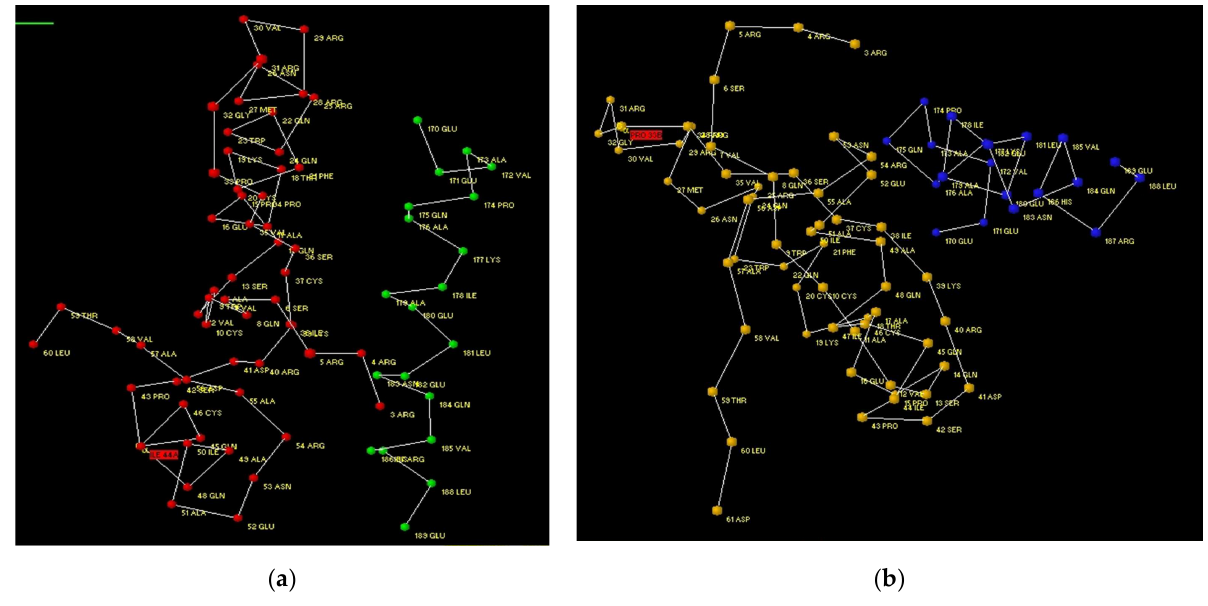
Figure 3. Fragments of LF–PSP complex used for analysis: complex between A (red) and C (green) subunits ( а ), complex between B (yellow) and D (blue) subunits ( b ).